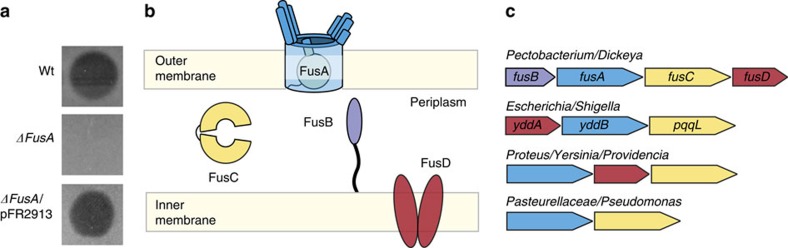
FusA from Pectobacterium is responsible for susceptibility to the ferredoxin domain containing bacteriocin pectocin M1(a) Purified pectocin M1 spotted onto iron-limiting Lysogeny broth (LB) agar plus IPTG overlaid with a lawn of soft agar seeded with P. atrosepticum LMG2386, Wt, ΔfusA or ΔfusA complemented with a plasmid derived copy of fusA with an IPTG inducible promoter. Genetic knockout of fusA totally abolishes susceptibility of the strain to pectocin M1, while complementation of the knockout strain with plasmid encoded fusA restores the pectocin M1 susceptible phenotype (experiment repeated >6 times). (b) A schematic of the proteins of the Fus operon showing their predicted cellular localization and function. (c) The genetic organization of the putative Fus operon in Pectobacterium spp. and homologous genes from a subset of human pathogens.